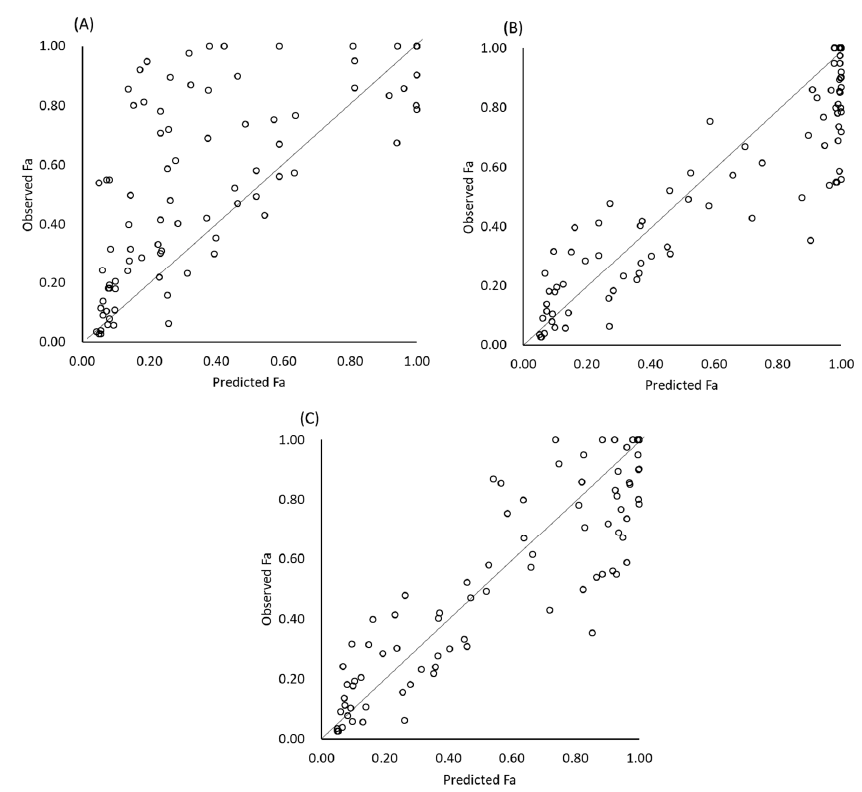
Figure 1. Predicted and observed Fa. ( A ) No gastric dissolution, ( B ) using bulk pH, and ( C ) using pH surface and pH eq . Table 4. Statistics of Fa prediction.